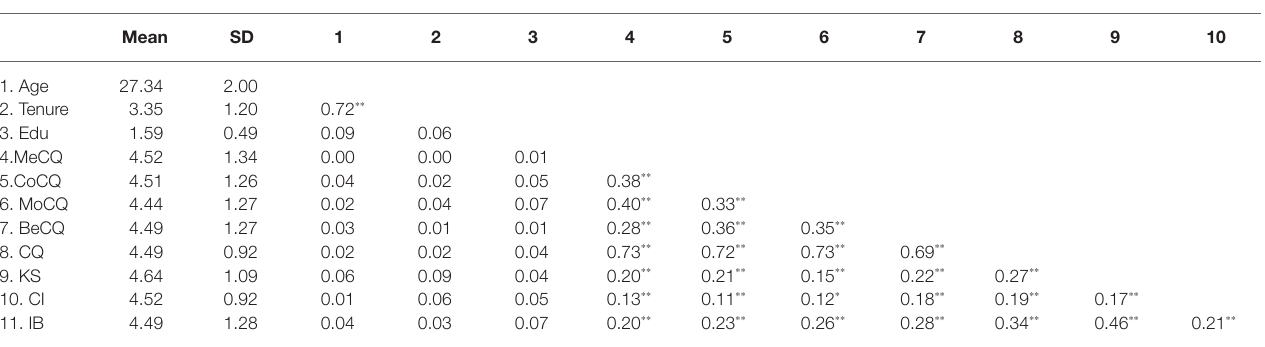
TABLE 2 | Means, standard deviations, and correlations among study variables.